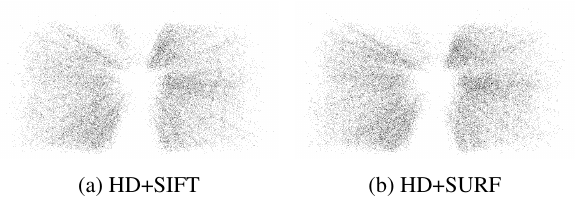
Figure 7. The maps of tie points for HD images in D 1 . The image points are detected without GRID